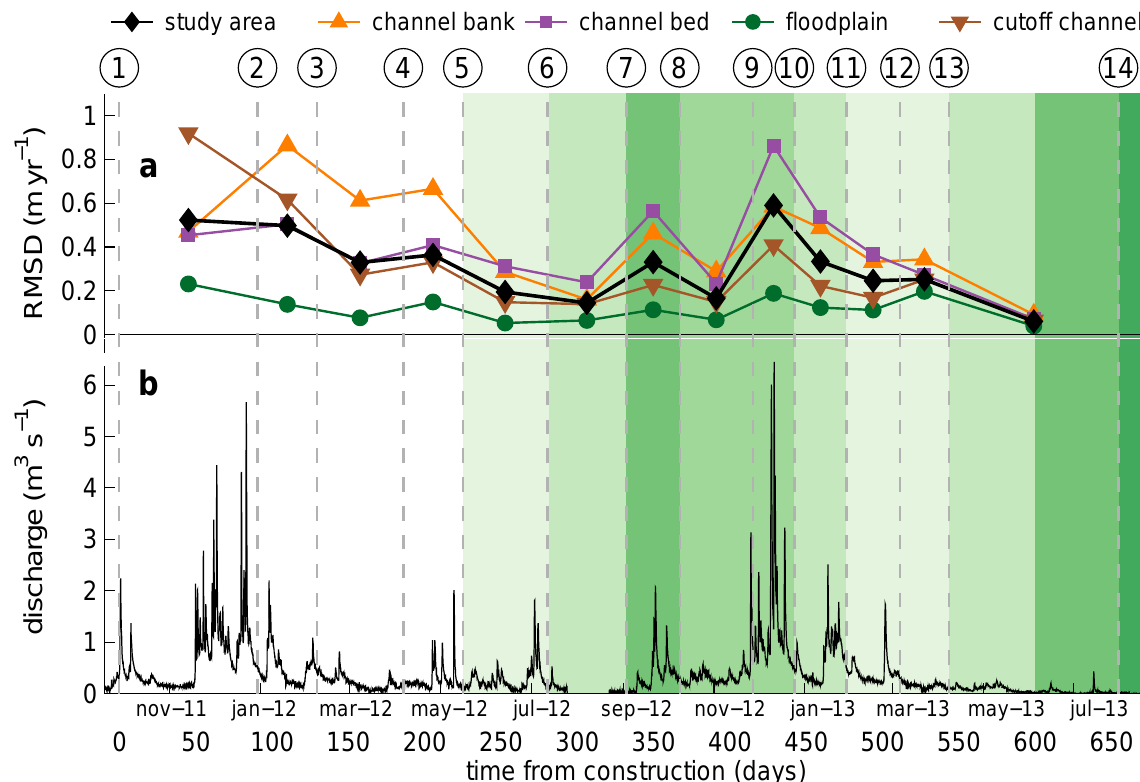
Figure 10. Temporal evolution of (a) the rate of morphological change (myear − 1 ) for the study area as a whole (black diamonds) and specified per morphological feature, with channel bank (orange triangles), channel bed (purple squares), floodplain (green circles) and cutoff channel (brown triangles), as well as (b) discharge hydrograph (m 3 s − 1 ). The green shading indicates the riparian vegetation coverage, estimated from Fig. 9. The dashed vertical lines indicate the surveying moments, and the numbers at the top of the figure correspond to the numbers in Table